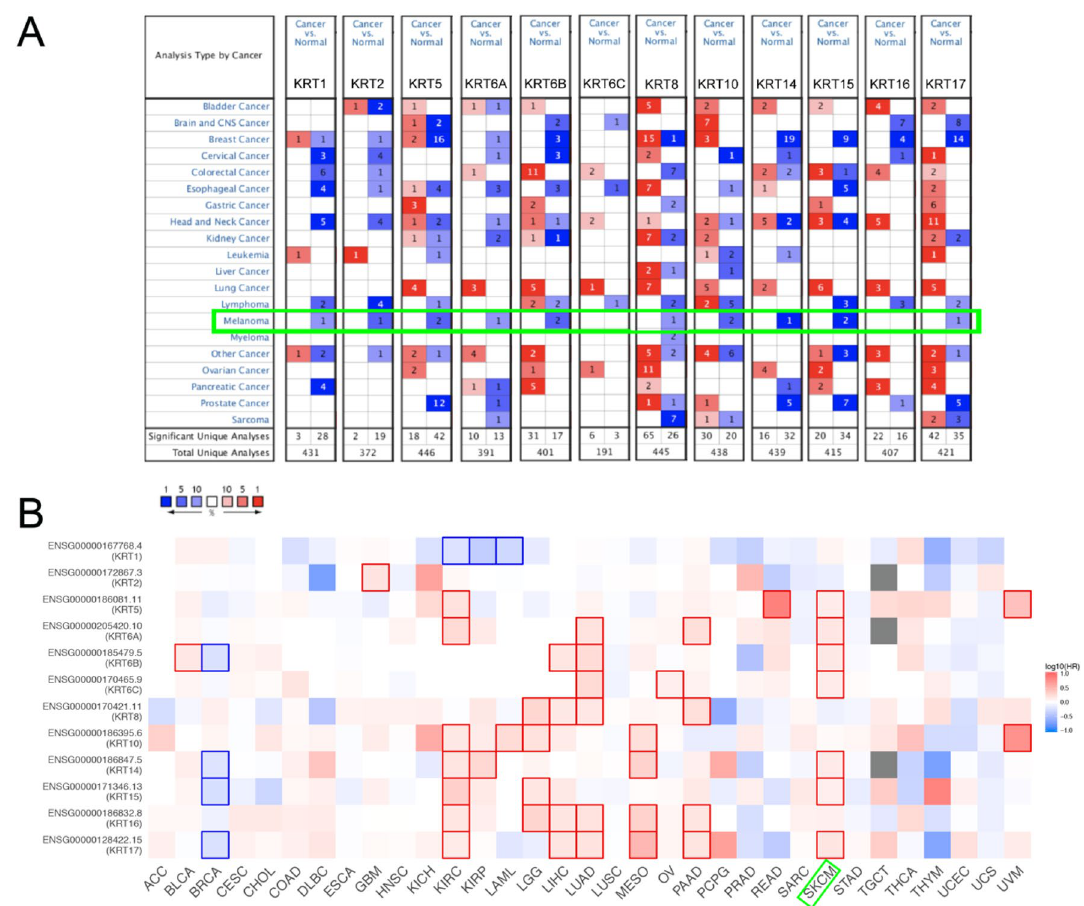
Figure 2. Expression level and survival analysis of KRTs . ( A ) Difference of transcriptional expression was compared by Students’ t-test. Cut-off of P value and fold change were as following: P value = 0.01, Fold Change = 1.5, gene rank = 10%, data type: mRNA. ( B ) Summary of hazard ratios (HR) illustrating cancer -KRT pairs with altered prognosis. (ACC, Adrenocortical Carcinoma; BLCA, Bladder Urothelial Carcinoma; BRCA, Breast Invasive Carcinoma; CESC, Cervical Squamous Cell Carcinoma and Endocervical Adenocarcinoma; CHOL, Cholangiocarcinoma; COAD, Colon Adenocarcinoma; DLBC, Lymphoid Neoplasm Diffuse Large B-cell Lymphoma; ESCA, Esophageal Carcinoma; HNSC, Head and Neck Squamous Cell Carcinoma; KICH, Kidney Chromophobe; KIRC, Kidney Renal Clear Cell Carcinoma; KIRP, Kidney Renal Papillary Cell Carcinoma; LAML, Acute Myeloid Leukemia; LGG, Brain Lower Grade Glioma; LIHC, Liver Hepatocellular Carcinoma; LUAD, Lung Adenocarcinoma; LUSC, Lung Squamous Cell Carcinoma; MESO, Mesothelioma; OV, Ovarian Serous Cystadenocarcinoma; PAAD, Pancreatic Adenocarcinoma; PCPG, Pheochromocytoma and Paraganglioma; PRAD, Prostate Adenocarcinoma; READ, Rectum Adenocarcinoma; SARC, Sarcoma; SKCM, Skin Cutaneous Melanoma; STAD, Stomach Adenocarcinoma; TGCT, Testicular Germ Cell Tumors; THCA, Thyroid carcinoma; THYM, Thymoma; UCEC, Uterine Corpus Endometrial Carcinoma; UCS, Uterine Carcinosarcoma; UVM, Uveal